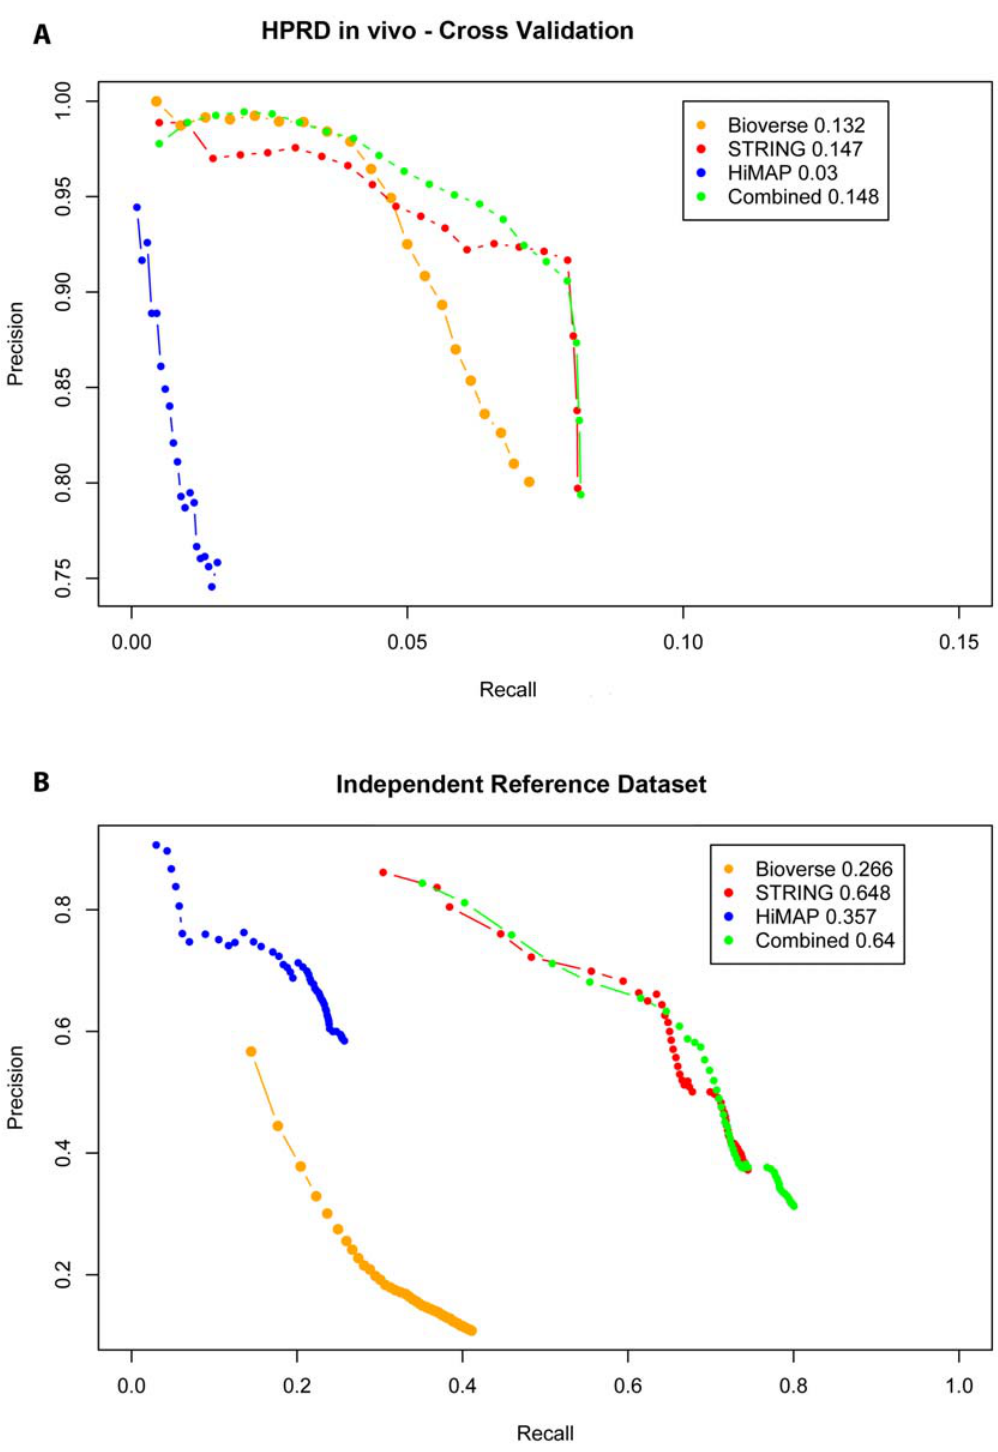
Figure 6. Benchmarking the integrated interactome. (A) Cross validation based on the HPRD in vivo reference set. (B) Training on HPRD in vivo , testing on independent reference set (see main text for details). We divided the test dataset in 20 bins based on their descending log-likelihood score and assessed the cumulative precision and recall for each successive bin for the corrected score and for the scores derived from training the individual databases. The integrated network shows equal or better overall performance. The maximum F-score of each network is reported in the legend. The F-score ( 2 (cid:1) precision (cid:1) recall = precision z recall ð Þ ) is an integrated measure of the predictive power.